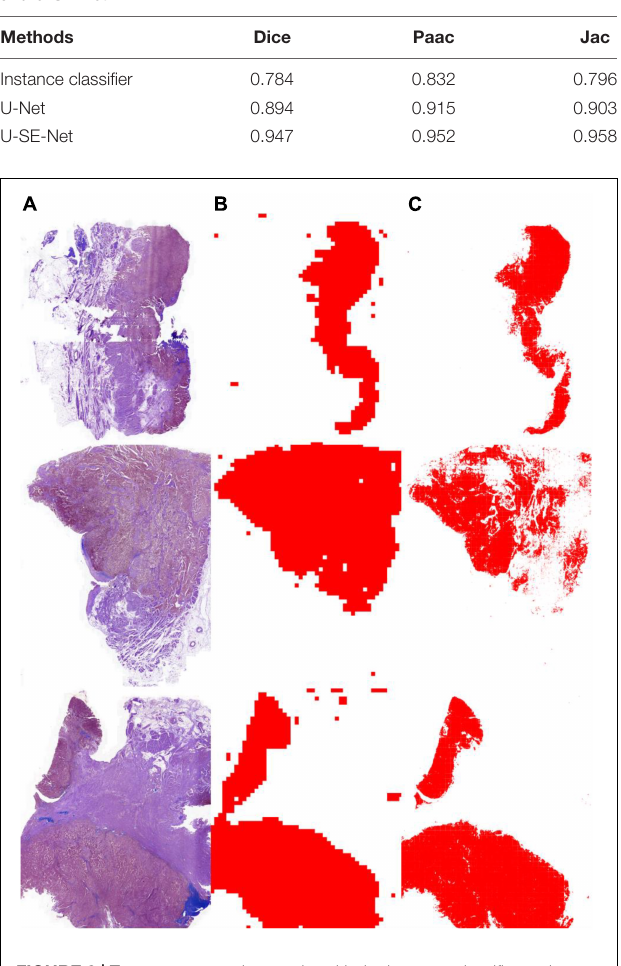
FIGURE 3 | Tumor segmentation results with the instance classifier and U-SE-Net. (A) pathological images; (B) segmentation results with the instance classifier (red masks); (C) segmentation results with U-SE-Net (red masks).